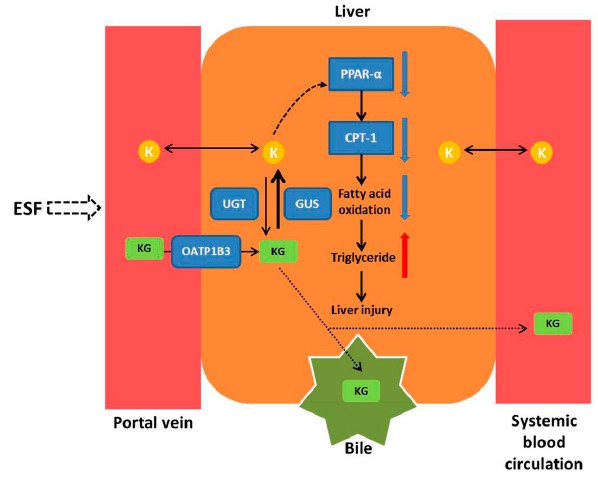
Figure 10. The mechanism of hepatotoxicity induced by Sophora flavescens . Key: K, kurarinone; KG, kurarinone glucuronides; UGT, UDP-glucuronosyltransferase; GUS, β -glucuronidase; PPAR- α , peroxisome proliferator-activated receptor-alpha; CPT-1, carnitine palmitoyltransferase-1.